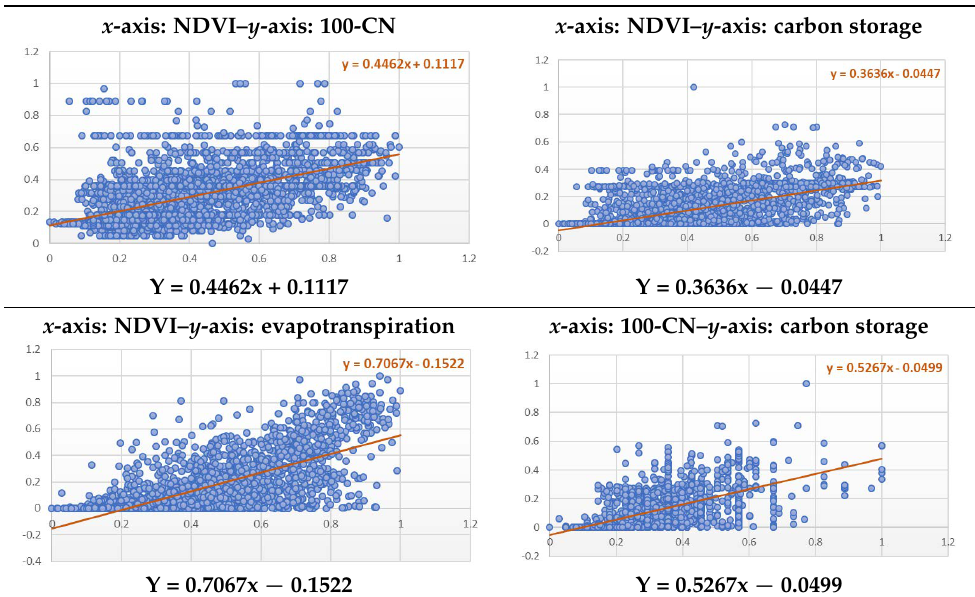
Table A7. Linear regression slopes: type